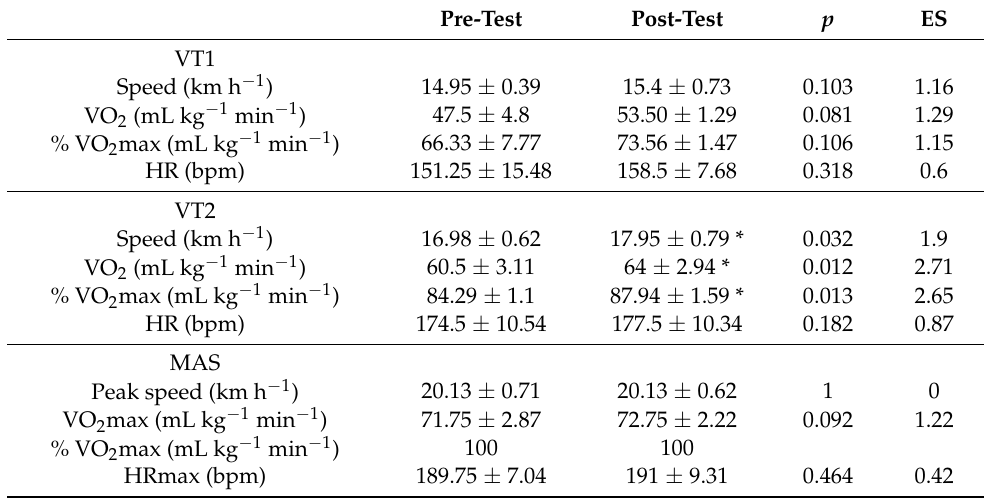
Table 2. Physiological characteristics (means ± SD) of the triathletes pre- and